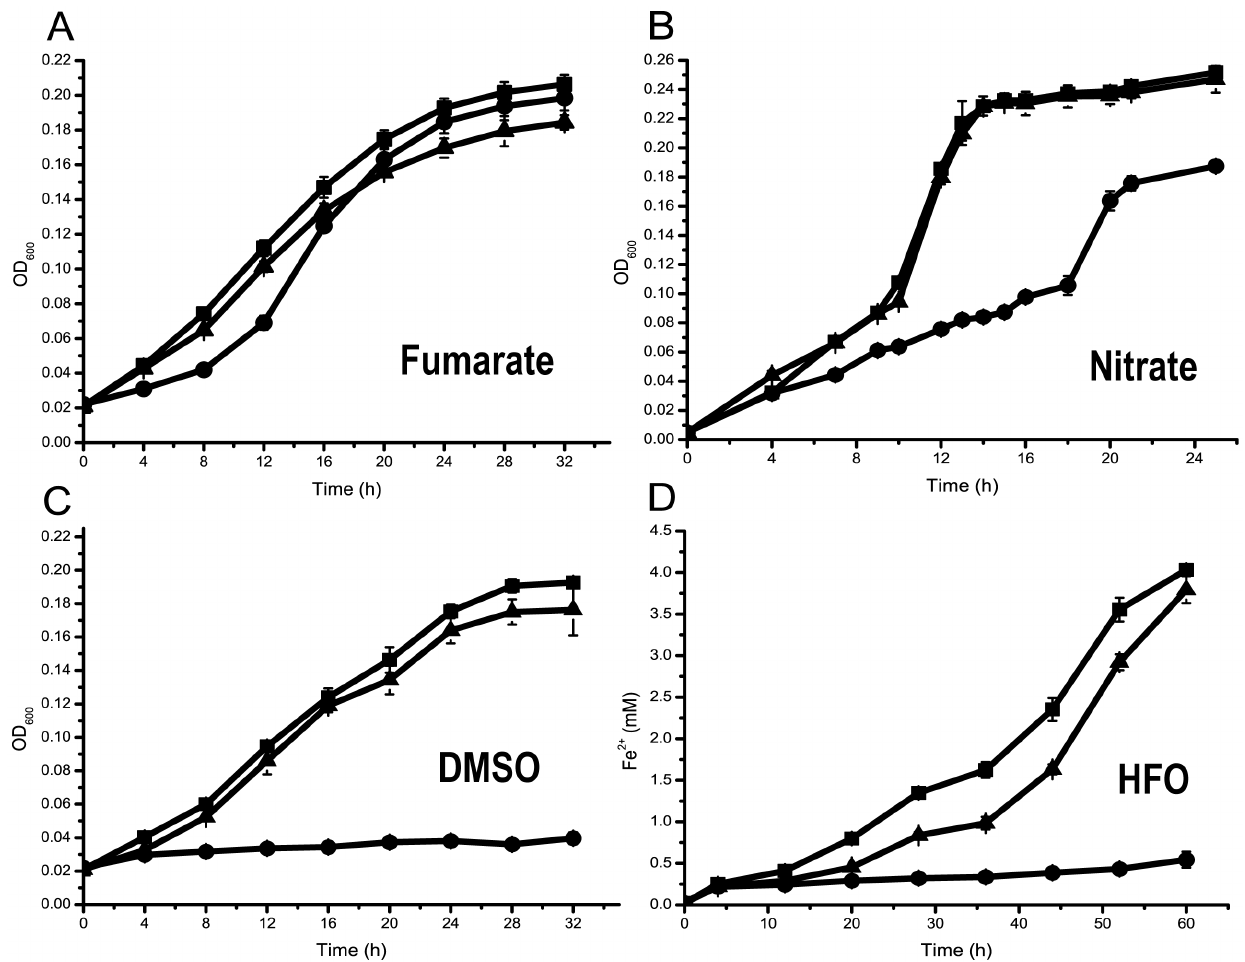
Figure 2. Growth curves of the WT WP3, fur mutant, and fur complement strains with different electron acceptors under anaerobic conditions. ( a–c ) Growth on 20 mM fumarate, 2 mM nitrate, and 20 mM DMSO as the electron acceptor, respectively. ( d ) Time course of Fe 2 + concentration with 15 mM HFO as an electron acceptor. The following abbreviations are used for all of the panels: ( & ) WT WP3, ( fur complement strain. The data represent averages of triplicate cultures.